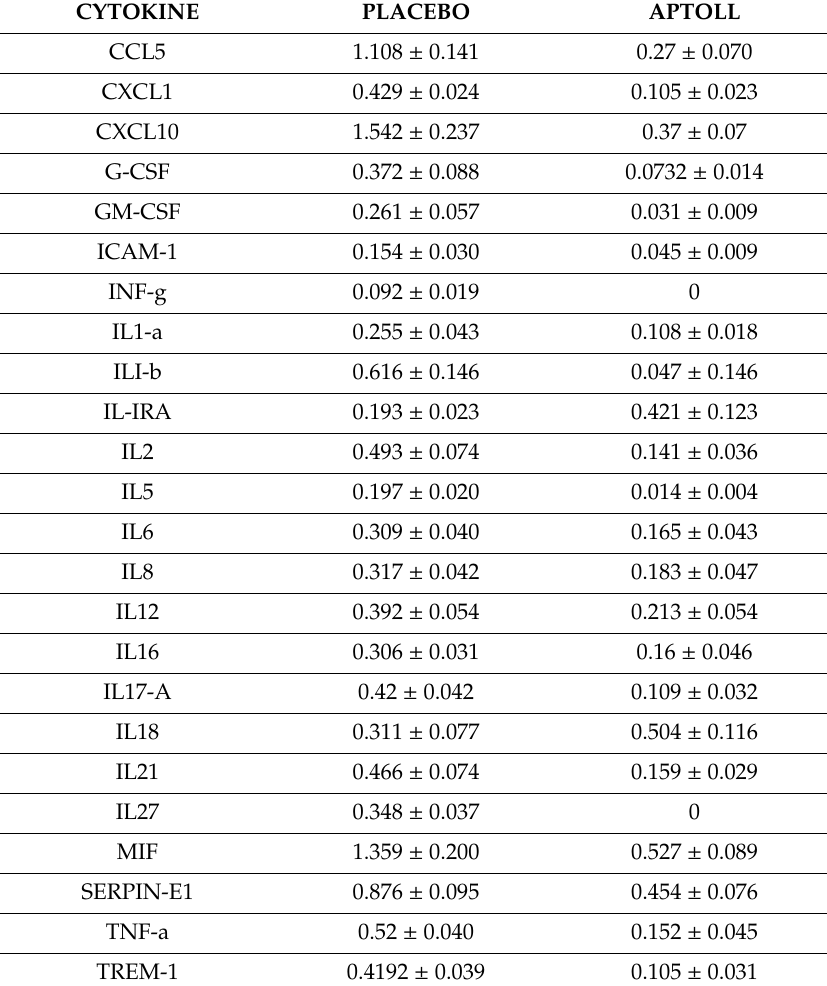
Table 2. Plasma levels of cytokines di ff erentially expressed 7 days after